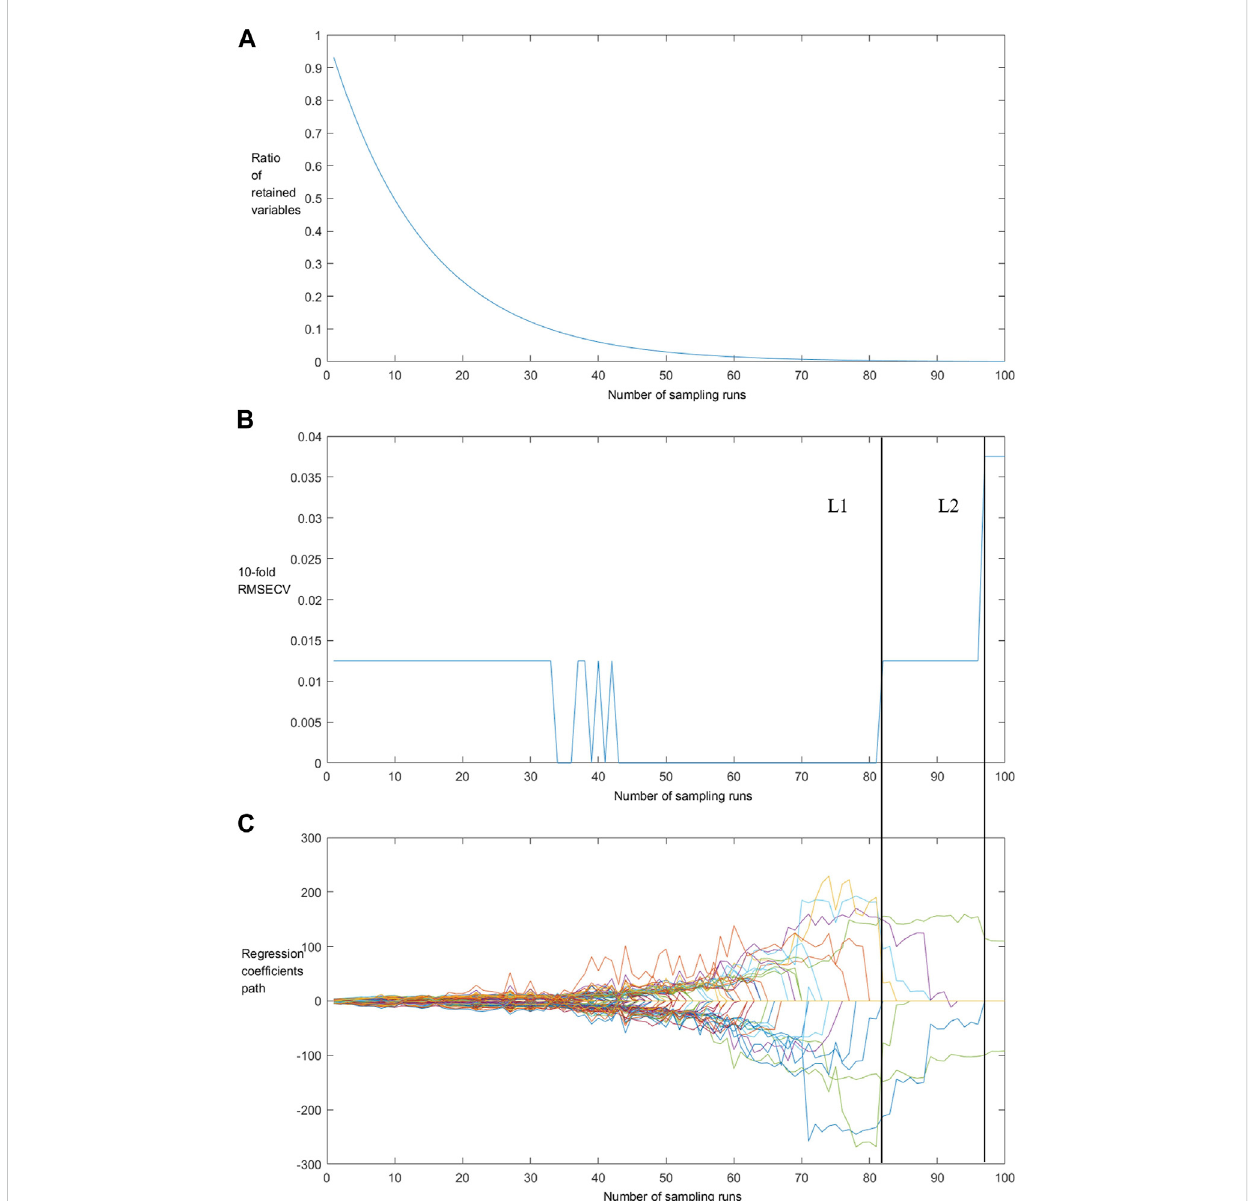
FIGURE 3 The changing trend of the ratio of retained variables (A) , 10-fold RMSECV values (B) and regression coef fi cients of each variable (C) with the increasing of sampling